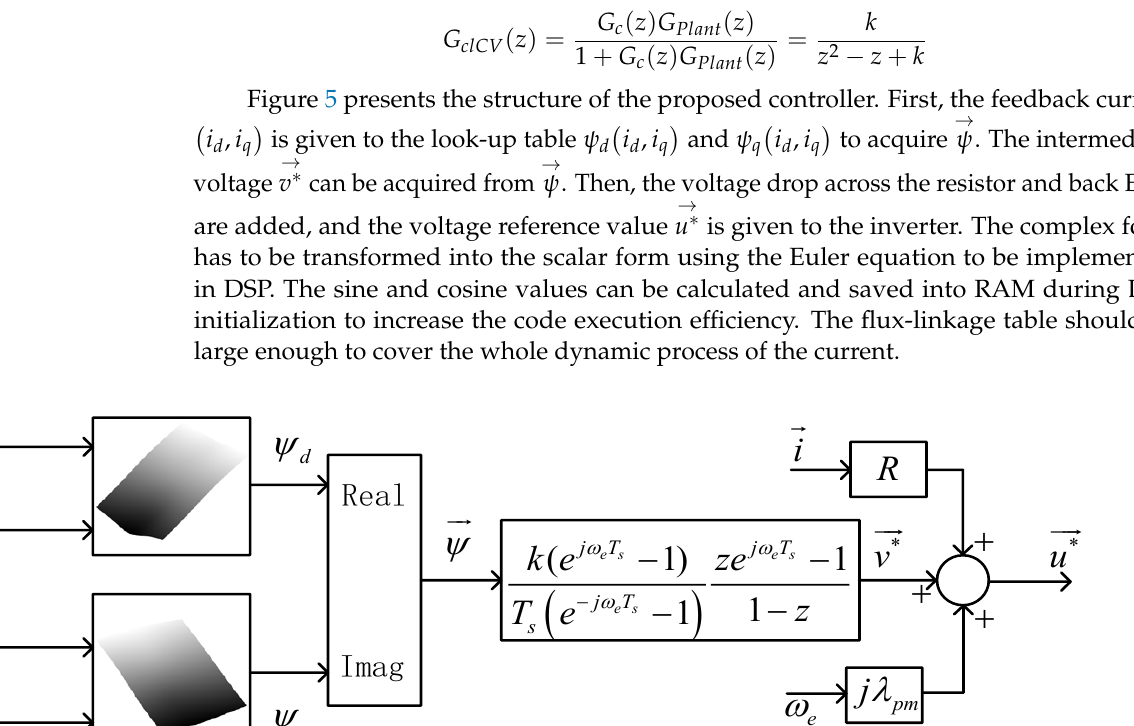
Figure 6. Step response of ideal closed-loop transfer function with different parameters. 0